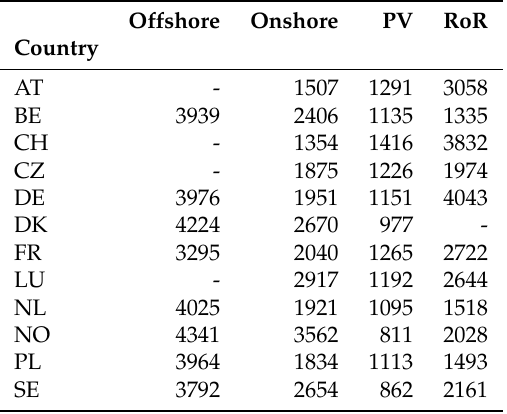
Table A4. Full load hours of onshore, offshore, pv and run of river (RoR) supply.